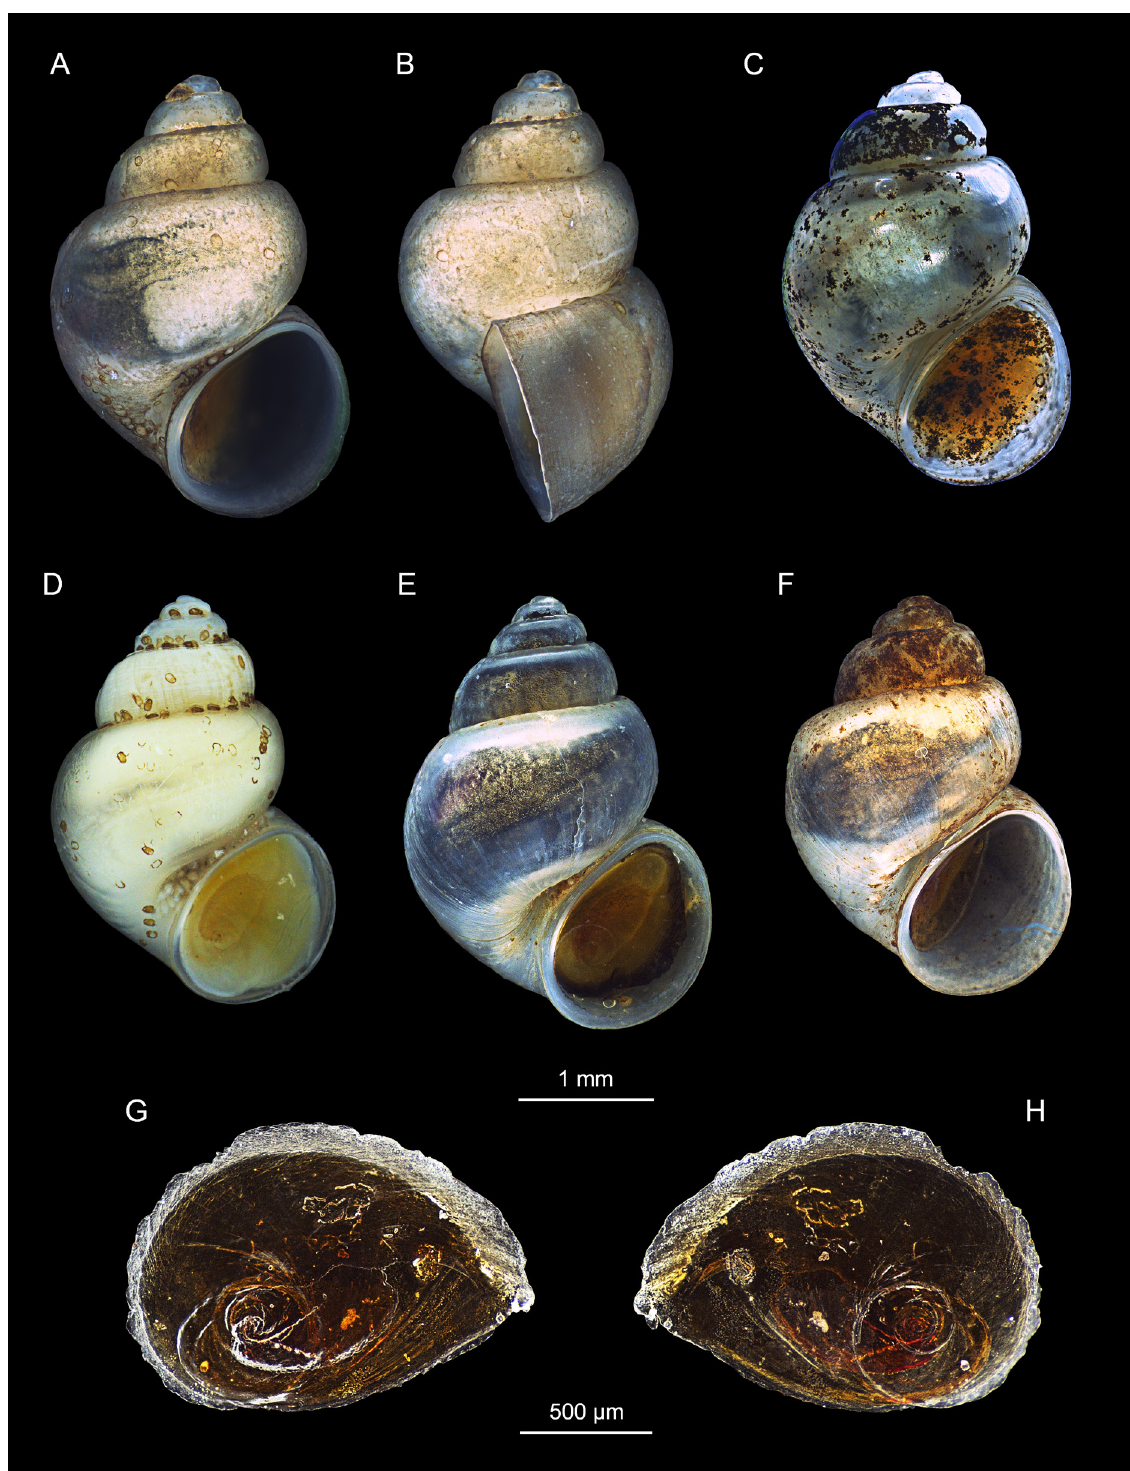
Fig. 11. Shells and operculum of Mercuria balearica (Paladilhe, 1869). A–B, G–H . Stream at Sant Joan de Carbonell, Minorca, Spain. C . Colarsega River, near the Port of Mahon (type locality). D . Fuente Árabe Spring, Mojácar, Granada, Spain (unpigmented specimen). E . Venta El Pilar Spring, Málaga, Spain. F . Spring, Alozaina, Cádiz, Spain. G . Operculum, inner side. H . Operculum, outer